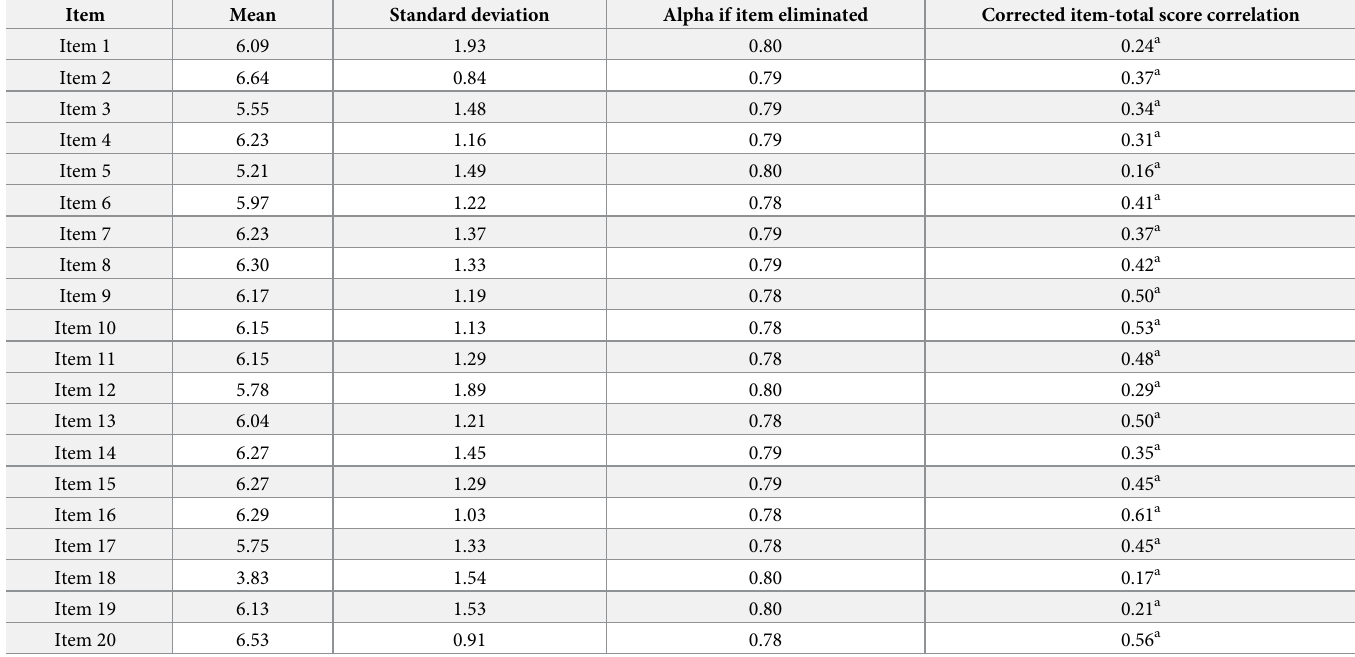
Table 1. Reliability of JSE-HP in its Spanish version applied to a national sample of 2,268 students at the beginning of academic year from 8 campuses of colleges of medicine in